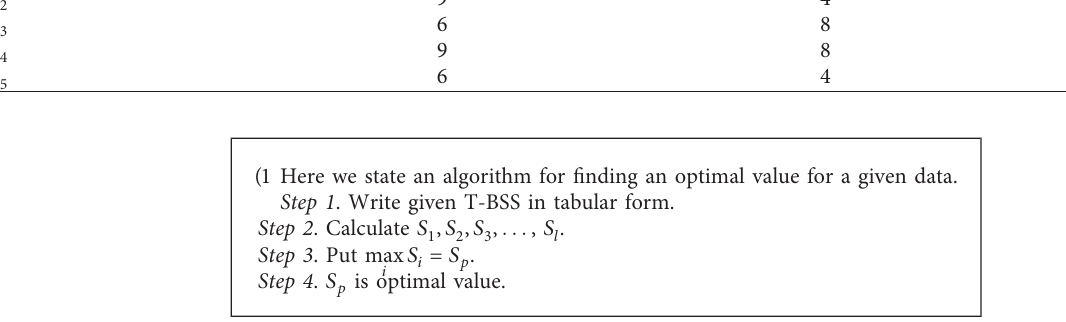
Table 4: Scores of a